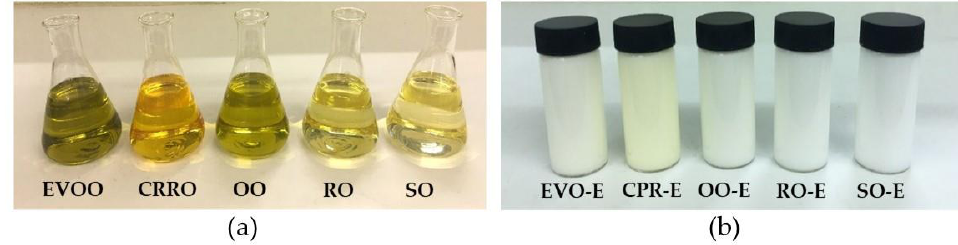
Figure 1. Visual appearance of ( a ) vegetable oils, ( b ) conventional emulsions (-E) prepared with the different oils: extra virgin olive oil (EVO-E), cold-pressed rapeseed oil (CPR-E), olive oil (OO-E), rapeseed oil (RO-E), sunflower oil (SO-E).